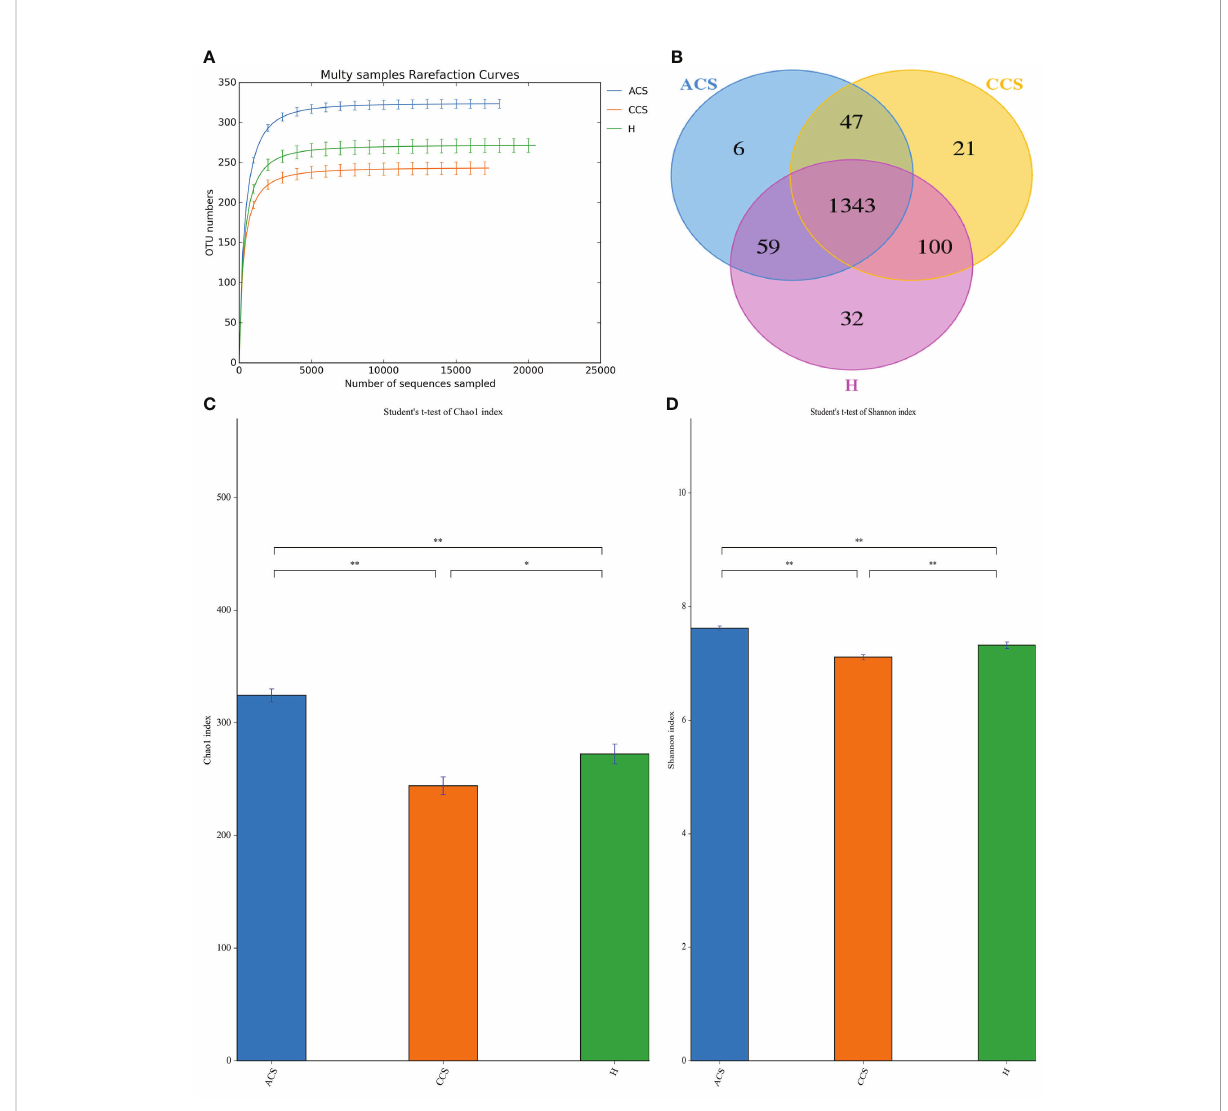
FIGURE 1 OTUs curve and Venn diagram of ACS, CCS, and H groups. (A) Curves illustrate species accumulation between the number of samples and the estimated richness. In each group, the predicted OTU richness was close to saturation. (B) A Venn diagram displaying the overlaps among ACS, CCS, and H groups. (C) Represent the Chao1 index between three groups. (D) Shows the Shannon index between three groups. OTUs, Operational taxonomic units; ACS, Acute coronary syndrome; CCS, Chronic coronary syndrome; H, healthy. "*" represent signi fi cance "**" shows strong signi fi cane.